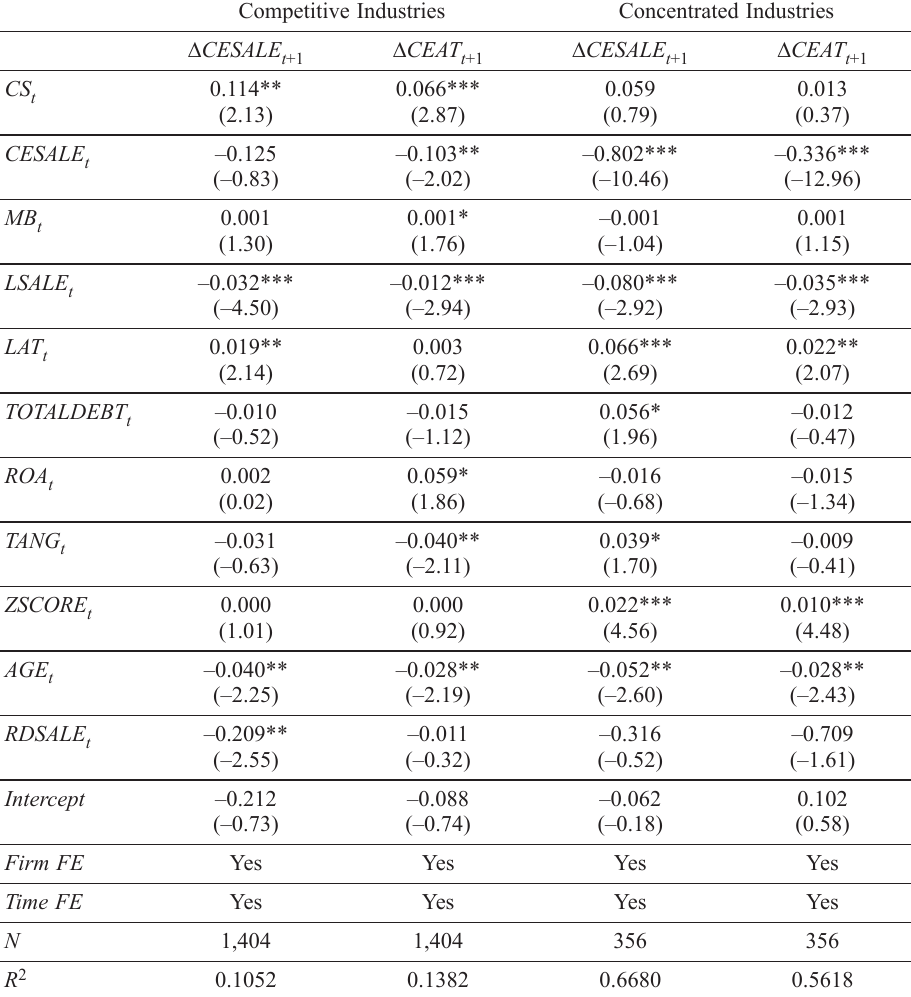
Table 5. Customer satisfaction, industry competition and capital